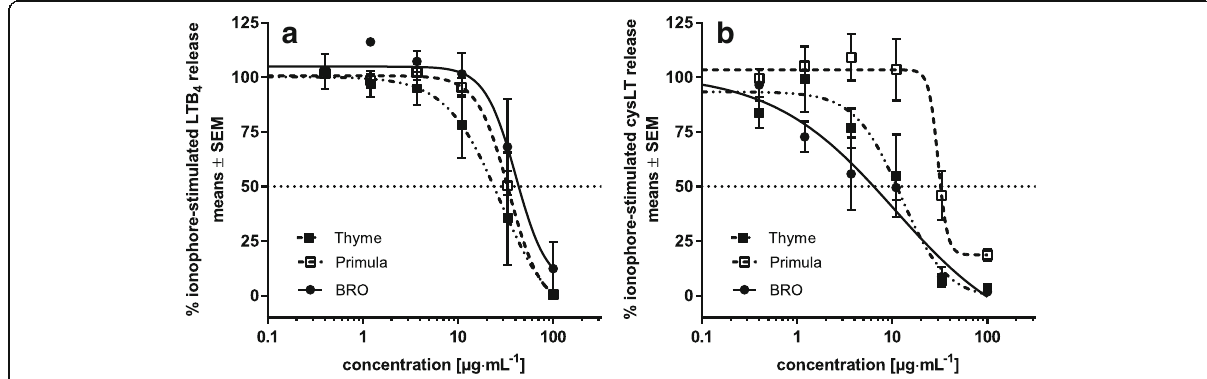
Fig. 3 Ca 2+ -ionophore-stimulated release of the eicosanoids ( a ) LTB 4 from human neutrophils and ( b ) cysLT from human monocytes in the presence of increasing concentrations of BRO or of the single extracts from thyme and primula. Data shown are means ± SEM; n =3 (individual experiments)